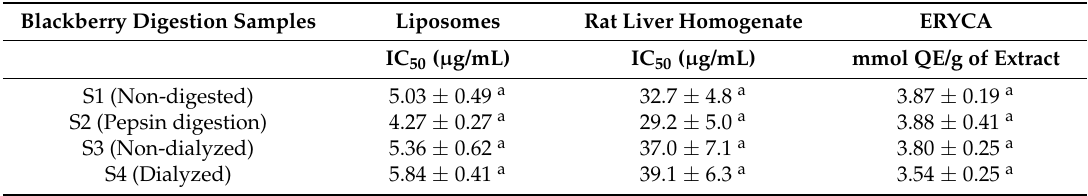
Table 3. Lipid peroxidation inhibitory capacity of the digested blackberry juice